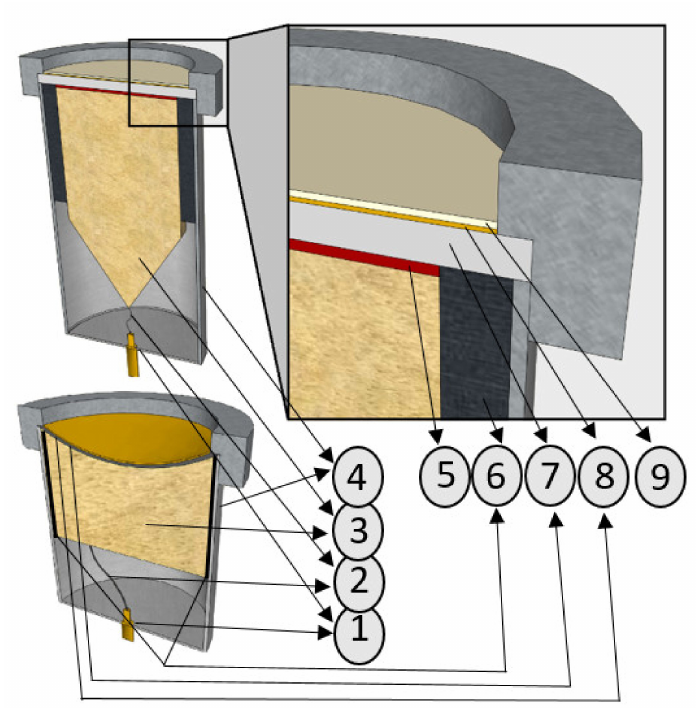
Figure 1. Transducer design for flat and spherically focused prototypes. 1: Connector, 2: wire, 3: backing block, 4: aluminum housing, 5: conductive tape, 6: insulating seal, 7: ferroelectret film, 8: Au coating, 9: Polymer